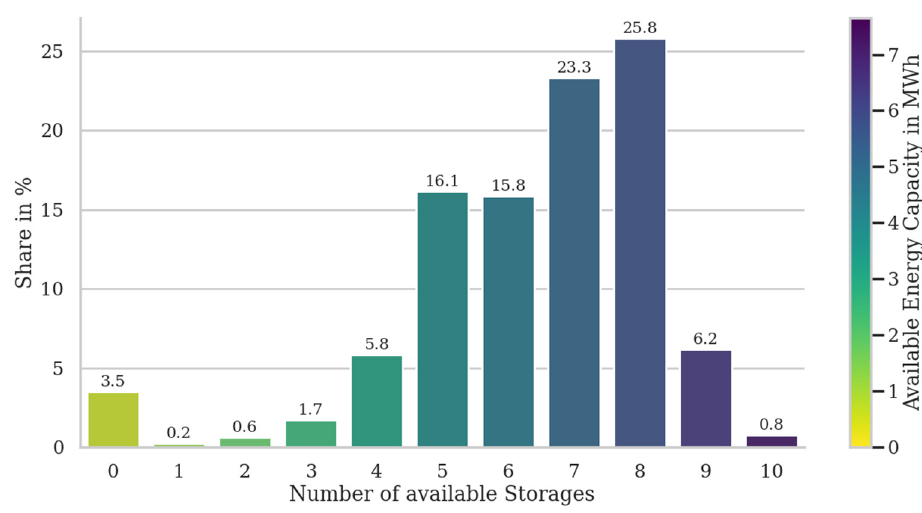
Figure 5. Share of the number of available battery units of the LSS with the associated, average storage energy capacity in MWh.